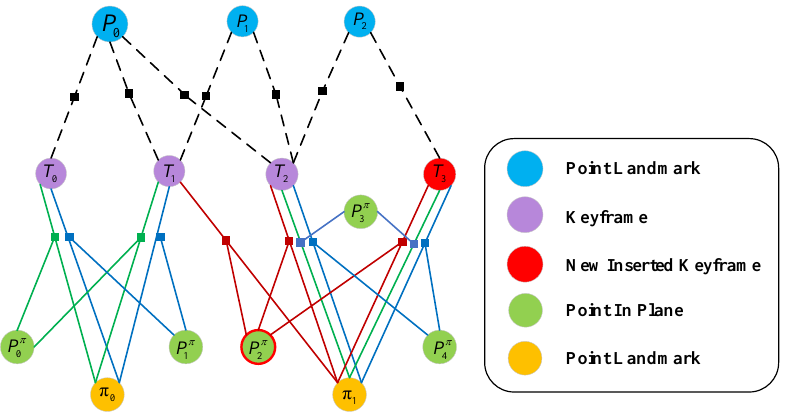
Figure 4. Factor graph